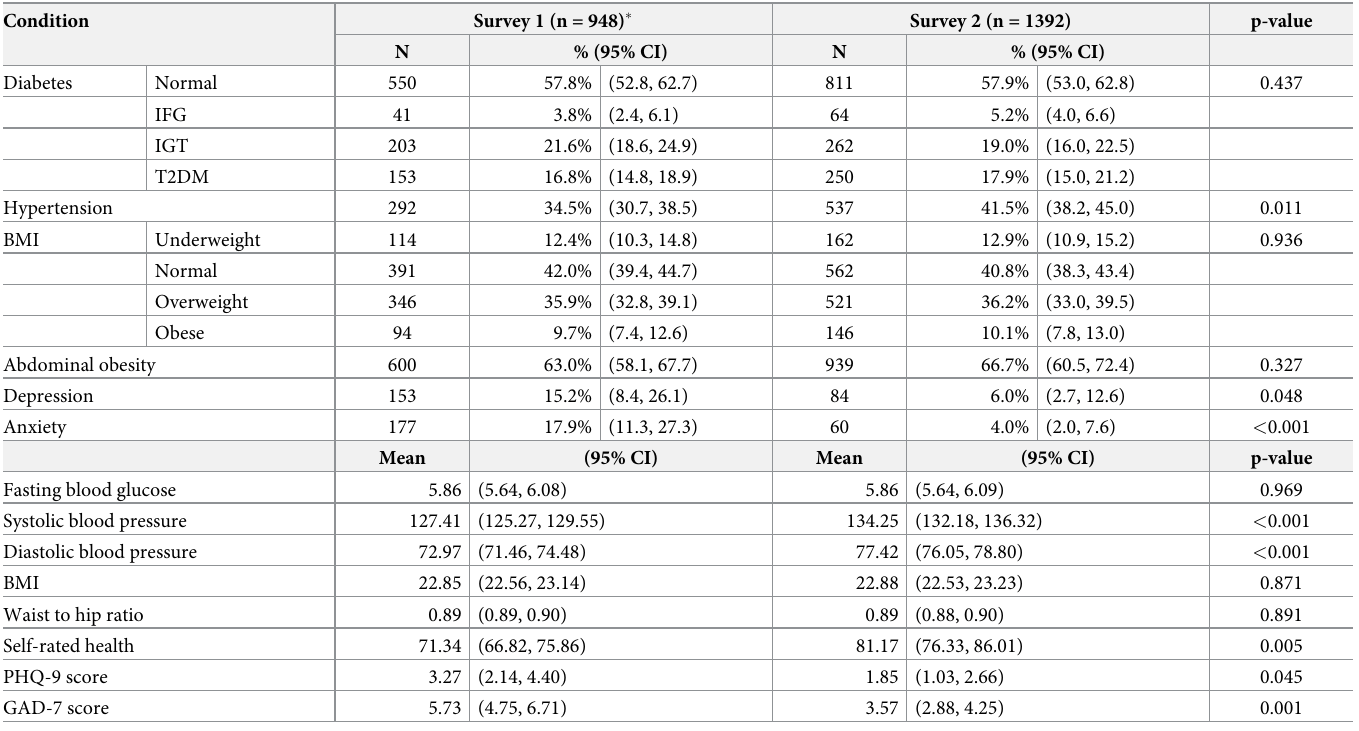
Table 3. Prevalence of non-communicable conditions in survey 1 and survey 2.